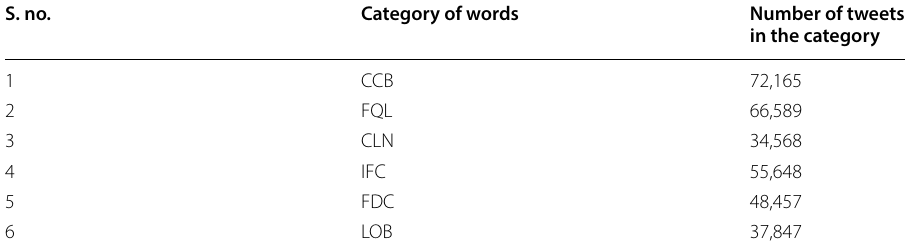
Table 2 The categories of words and number of tweets in which they occurred S.